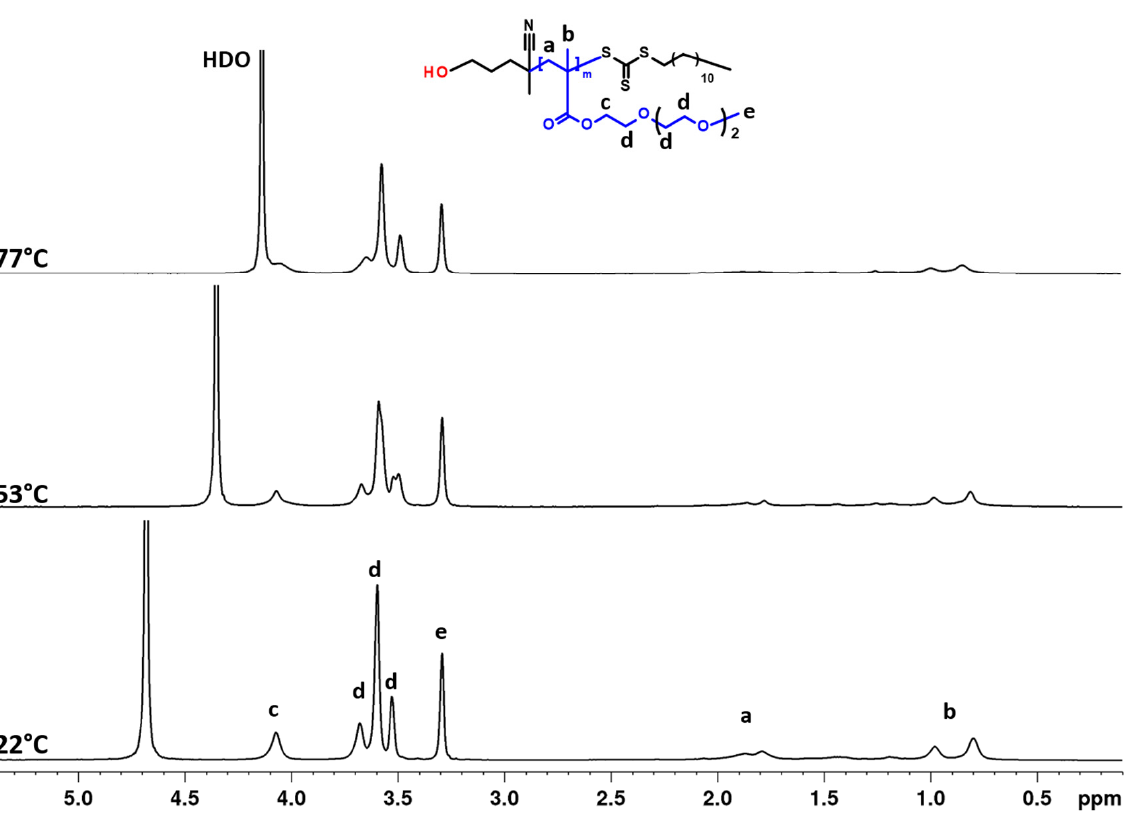
Figure 3. The 600.2 MHz 1 H NMR spectra of PTEGMA homopolymer in D2O solution (c = 2.5 mg · mL − 1 ) measured at 22, 53, and 77 ◦ C under the same instrumental conditions. High-resolution 1 H NMR spectra of prepared NPs (BC1, BC2, and BC3) and